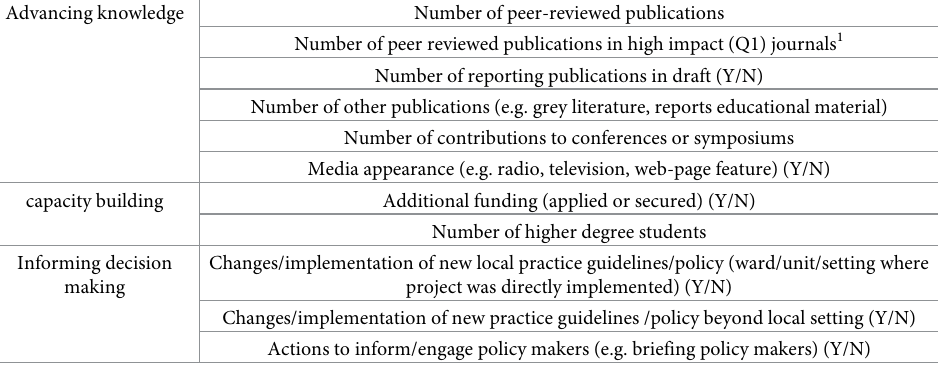
Table 1. Research impact